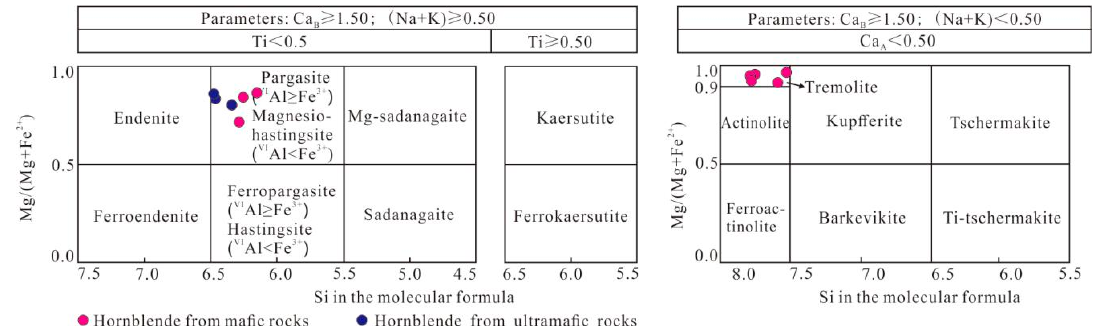
Figure 8. Classification diagram of calcium hornblende family in the Niubiziliang mafic-ultramafic complex (modified after Leake et al. (1997) [30]).